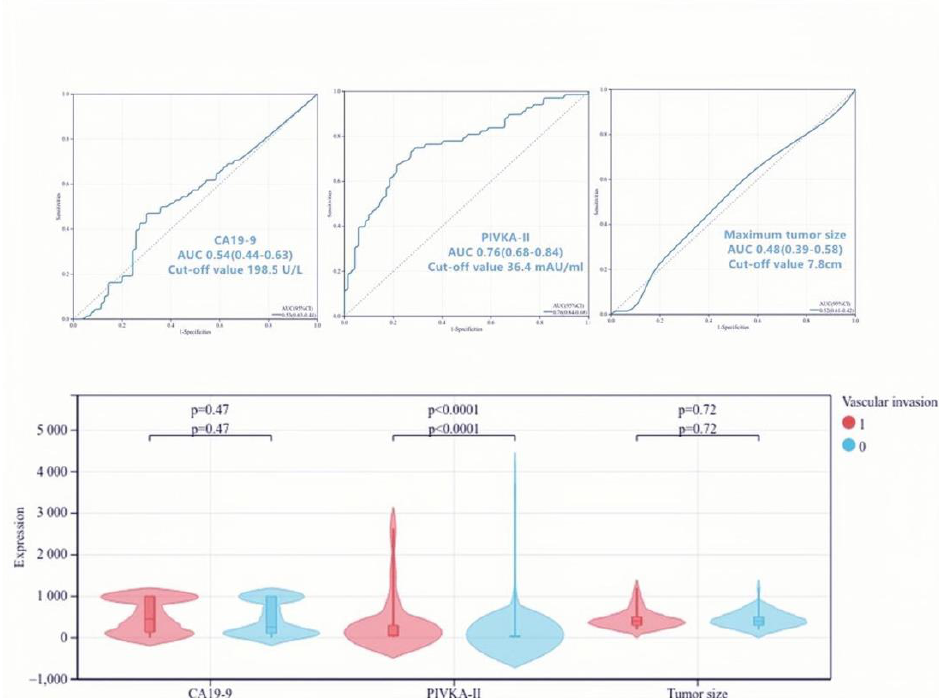
Figure 5. Cut-off values of PIVKA-II, CA19-9, and tumor size for predicting vascular invasion in pancreatic ductal adenocarcinoma. CA19-9 levels had no significant difference between patients with and without vascular invasion ( p = 0.47). The ROCs showed the cut-off value of CA19-9 was 198.5 U/L, and the AUC was 0.54 (95% CI, 0.44–0.63). PIVKA-II levels significantly differed between patients with and without vascular invasion ( p < 0.0001). The ROCs showed the cut-off value of PIVKA-II was 36.4 mAU/mL, and the AUC was 0.76 (95% CI, 0.68–0.84). Tumor size had no significant difference between patients with and without vascular invasion ( p = 0.72). The ROCs showed the cut-off value of maximum tumor size was 7.8 cm, and the AUC was 0.48 (95% CI, 0.39–0.58). AUC is the area under the curve; ROC is receiver operating characteristics; CI is confidence interval; PIVKA-II is protein induced by vitamin K absence-II; CA19-9 is carbohydrate antigen 19-9. Table 5. Univariate analysis and multivariate analysis for predictors of vascular invasion in pancreatic ductal